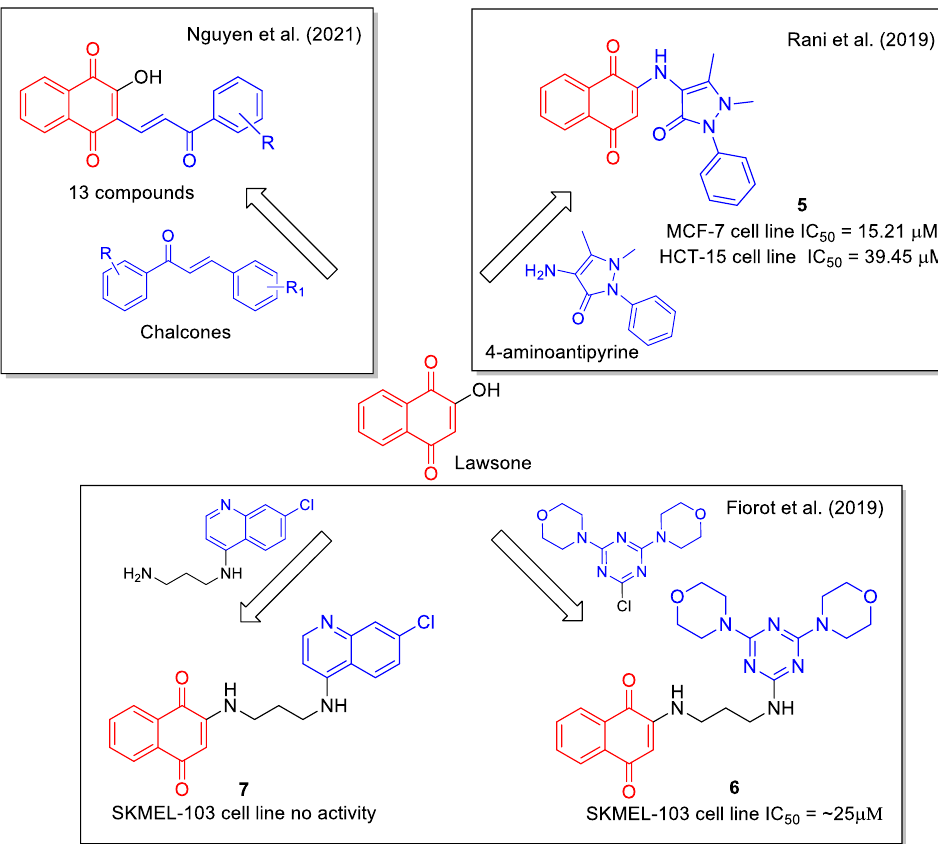
Figure 4. 1,4-Naphtoquinone hybrids with aminoantipyridine as reported by Rani et al. [29], with chloroquinoline by Fiorot et al. [30] and with chalcone by Nguyen et al. [31]. Lawsone, 4,7-dichloroquinoline, cyanuric chloride, and morpholine were used by Fiorot et al. [30] to synthesize three hybrids whose structures were designed based on docking calculation considering the interaction of the lead compound with the phospho- inositide 3-kinase and the 5 ′ AMP-activated protein kinase. Product 6 resulted to be the most cytotoxic towards human melanoma SKMEL-103 cells, whereas 7 showed no activity (Figure 4). Structurally defined as biaryl propenones, chalcones are very active against several cancer cell lines, with a mechanism of action involving interaction with tubulin and with its colchicine binding site. A series of naphthoquinone-based chalcone hybrids were ob- tained by Nguyen et al. [31] via a three-component reaction under microwave irradiation starting from lawsone, N,N -dimethyl-formamide dimethyl acetal and acetophenone de- rivatives (Figure 4). No biological evaluation was performed. A small library of amino-quinone hybrids was built by Bolognesi et al. [32], combin- ing 1,4-NQ, and the homologue anthraquinone and naphtacenequinone with polyamines, including natural spermidine and spermine and their synthetic variants. It is worth men- tioning that a quantitative yield of the products was obtained by the Michael addition using an excess of starting amine, which was then removed by polymer-supported sul- fonyl chloride and trisamine resin. According to the MTT assay, all synthetic compounds inhibited the growth of HT29 human colon adenocarcinoma cell line, with the highest activity observed for product 8 , while 9 caused apoptotic EGFR-mediated intracellular signaling (Figure 5). These results highlight the potential multiple activities of polyamine- quinone conjugates, also targeting tumors that have enhanced polyamine transporter (PAT) systems.